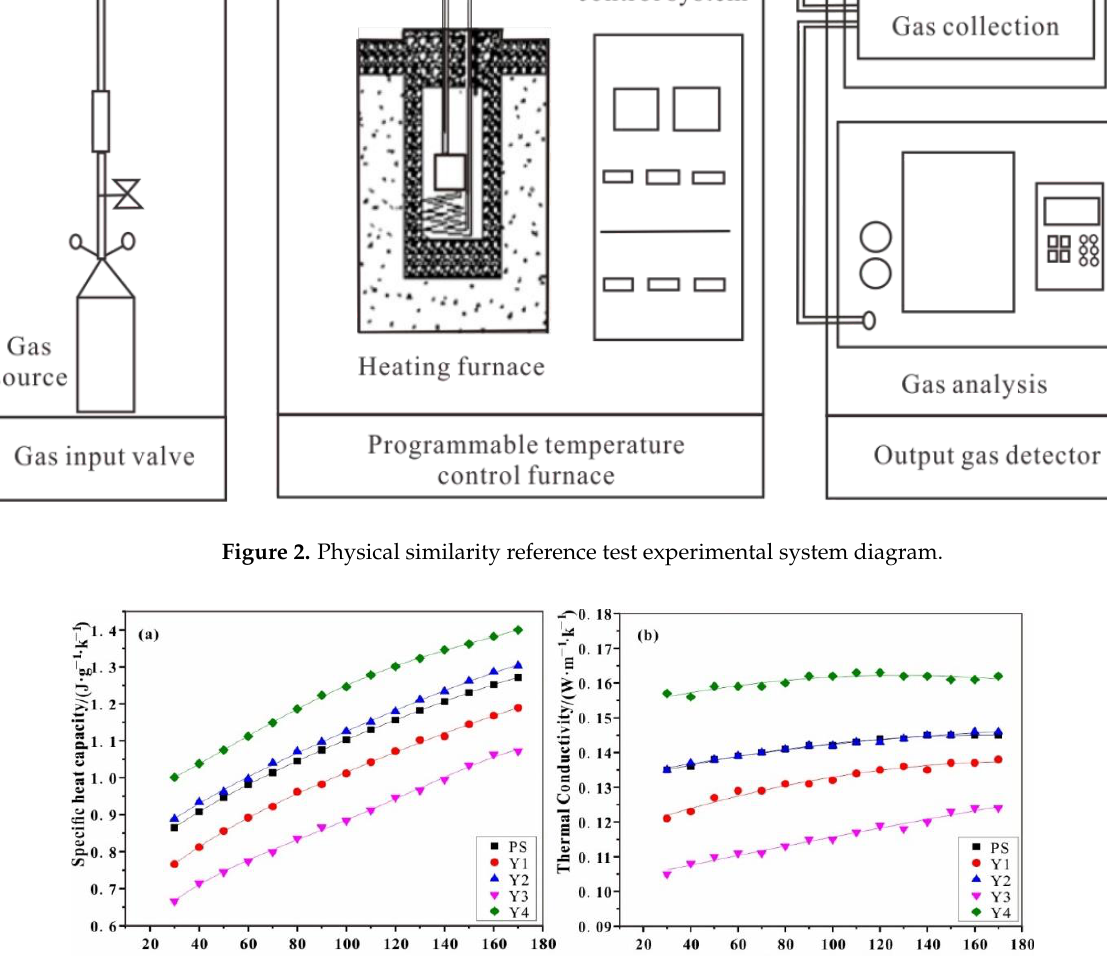
Figure 3. ( a ) Specific heat capacity curve of reference sample and coal sample; ( b ) thermal conductivity curve of reference sample and coal sample.